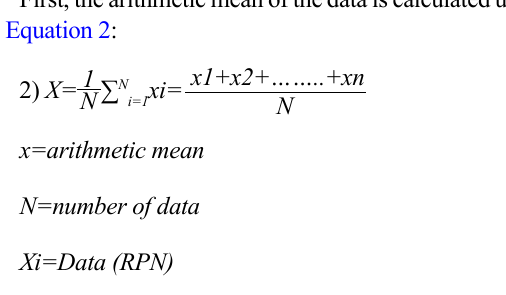
Table 2 . Ranking of the Error Effect Severity Index